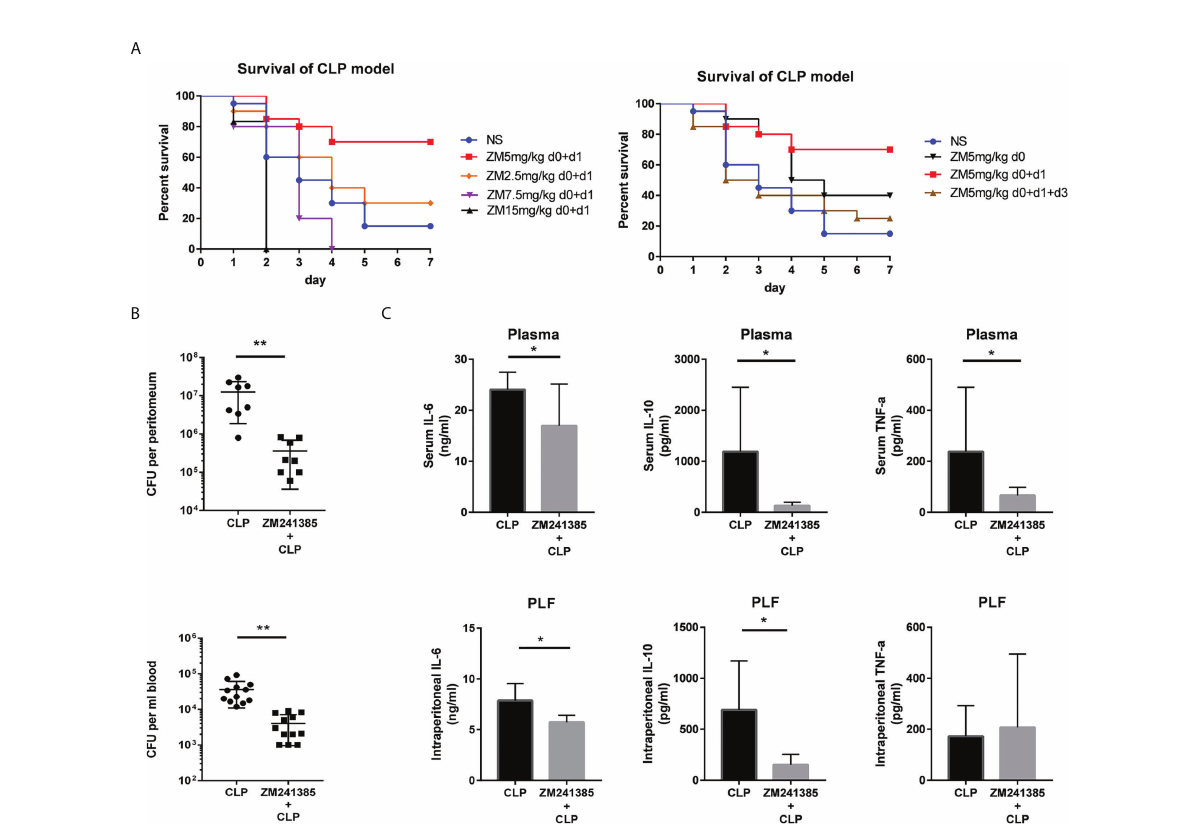
FIGURE 1 ZM241385 protects against CLP-induced mortality with reduced cytokine storm and improved bacterial clearance. Mice were subjected to CLP or ZM241385+CLP (n = 30 per group). Following CLP, the survival rates were assessed for a continuous 7 days. (A) Administration of 5 mg/kg of ZM241385 for 2 days led to a better effect than other doses in C57BL/6J mice. Statistical differences were determined by the log-rank test. (B) PLF and peripheral blood were taken 24 hours after CLP (n = 8-11 per group). Bacterial CFUs were calculated using 100 m L of each sample after dilution on Trypticase ™ soy agar blood plates. ZM241385-treated mice exhibited a lower bacterial burden. (C) Mice treated with the selective A2aR antagonist ZM241385 had lower levels of IL-10 and IL-6 in their plasma and peritoneum (5 mg/kg, delivered subcutaneously once daily). Comparing animals treated with ZM241385 to mice treated with a vehicle, TNF- a levels in the blood were reduced. Levels of IL-6, IL-10, and TNF- a were measured by ELISA in plasma and PLF obtained 24h after CLP. Data are presented as mean ± standard error of the mean values of n = 7-10 mice per group. These fi ndings are typical of three independent trials. The individual mice are represented by symbols. * p < 0.05, ** p <